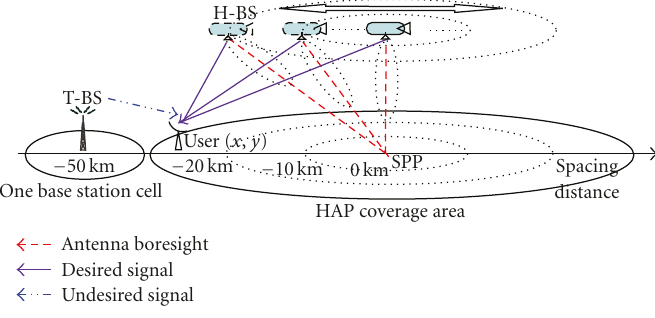
Figure 7: Illustration of changing of HAP spacing radius while keeping the antenna pointing o ff set at the center of serving area.